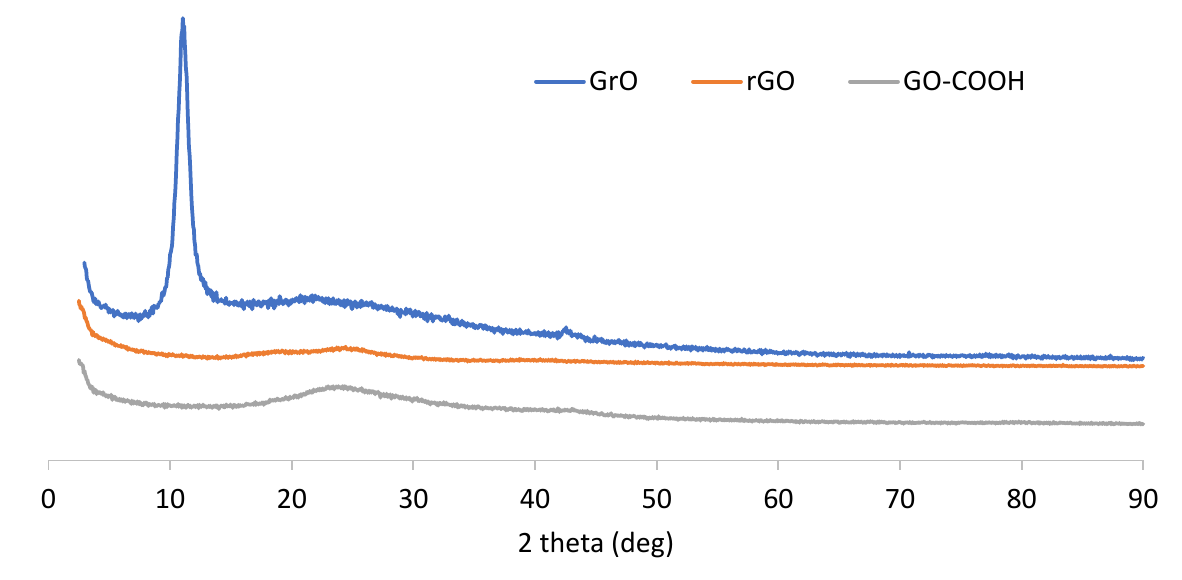
Figure 2. XRD diffractogram corresponding to GrO, rGO and GO-COOH powder samples. GrO, rGO and GO-COOH powder samples were also characterized by XPS. Table 1 shows the surface elemental composition relative to the studied elements. On one hand,